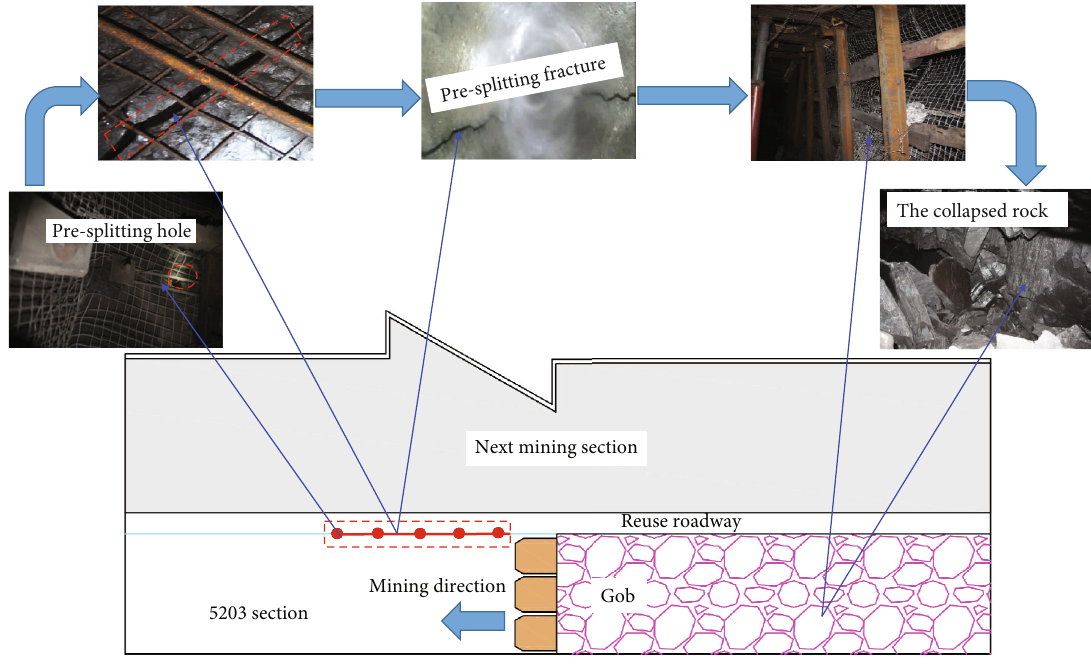
Figure 10: Expansion and penetration fi eld test of roof presplitting fractures.